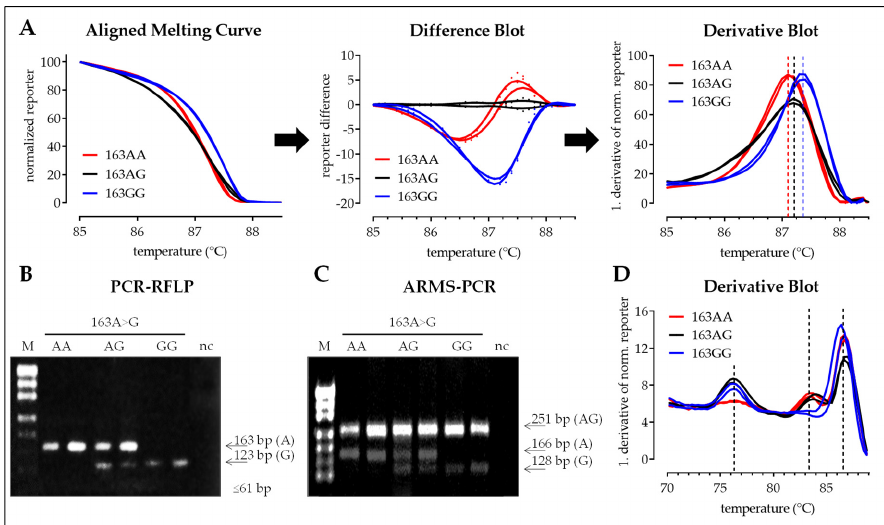
Figure 6. Detection of SNP 163A>G with four different methods: HRM-PCR, PCR-RFLP, conventional, and one-step ARMS-PCR. ( A ) High resolution melting curve analysis following SNP flanking PCR can be done using the aligned melting curve (normalized reporter), the resulting difference blot (difference of the normalized reporter with heterozygous samples as reference), or derivative blot (1. derivative of the normalized reporter). ( B ) Representative band pattern following enzymatic digestion of the SNP flanking PCR products with Sau96I (PCR-RFLP). ( C ) Representative band pattern of the conventional ARMS-PCR. ( D ) Melting curve analysis following one-step ARMS-PCR is performed with the derivative blot (1. derivative of the reporter). Presented data for the three methods were obtained from the same six samples.